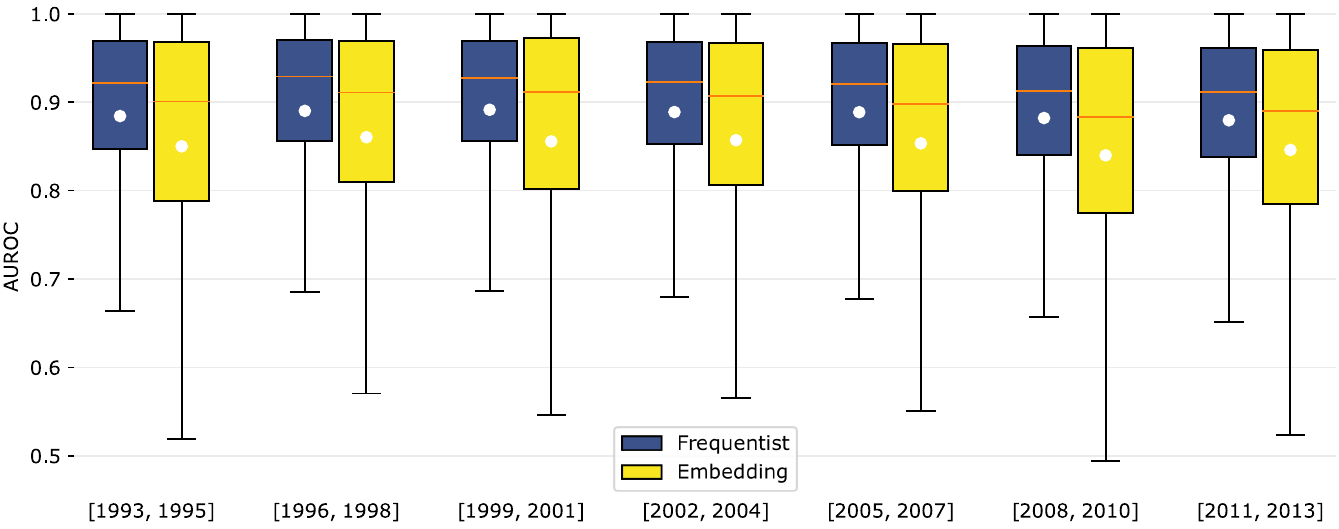
Fig 7. AUROC’s boxplots for scientists’ transitions (various periods). Boxplots of the AUROC for the 0 ! A transition for scientists. The orange horizontal line shows the median and the white circles shows the mean. Time windows for both model fitting and density estimation are shown in the x axis ( Δ windows for prediction testing begin immediately after the previous ones ( Δ test =